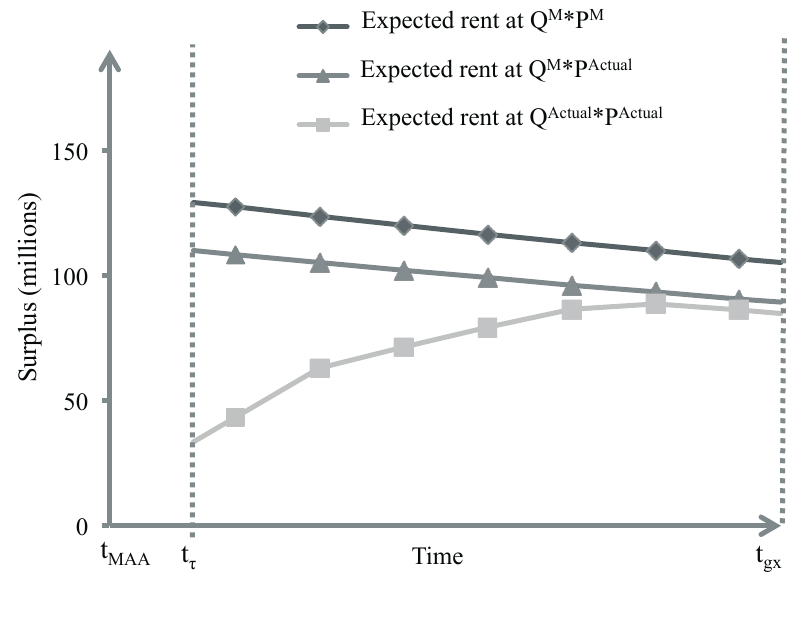
Figure 3a: Illustration of demand side policies impact on expected rent